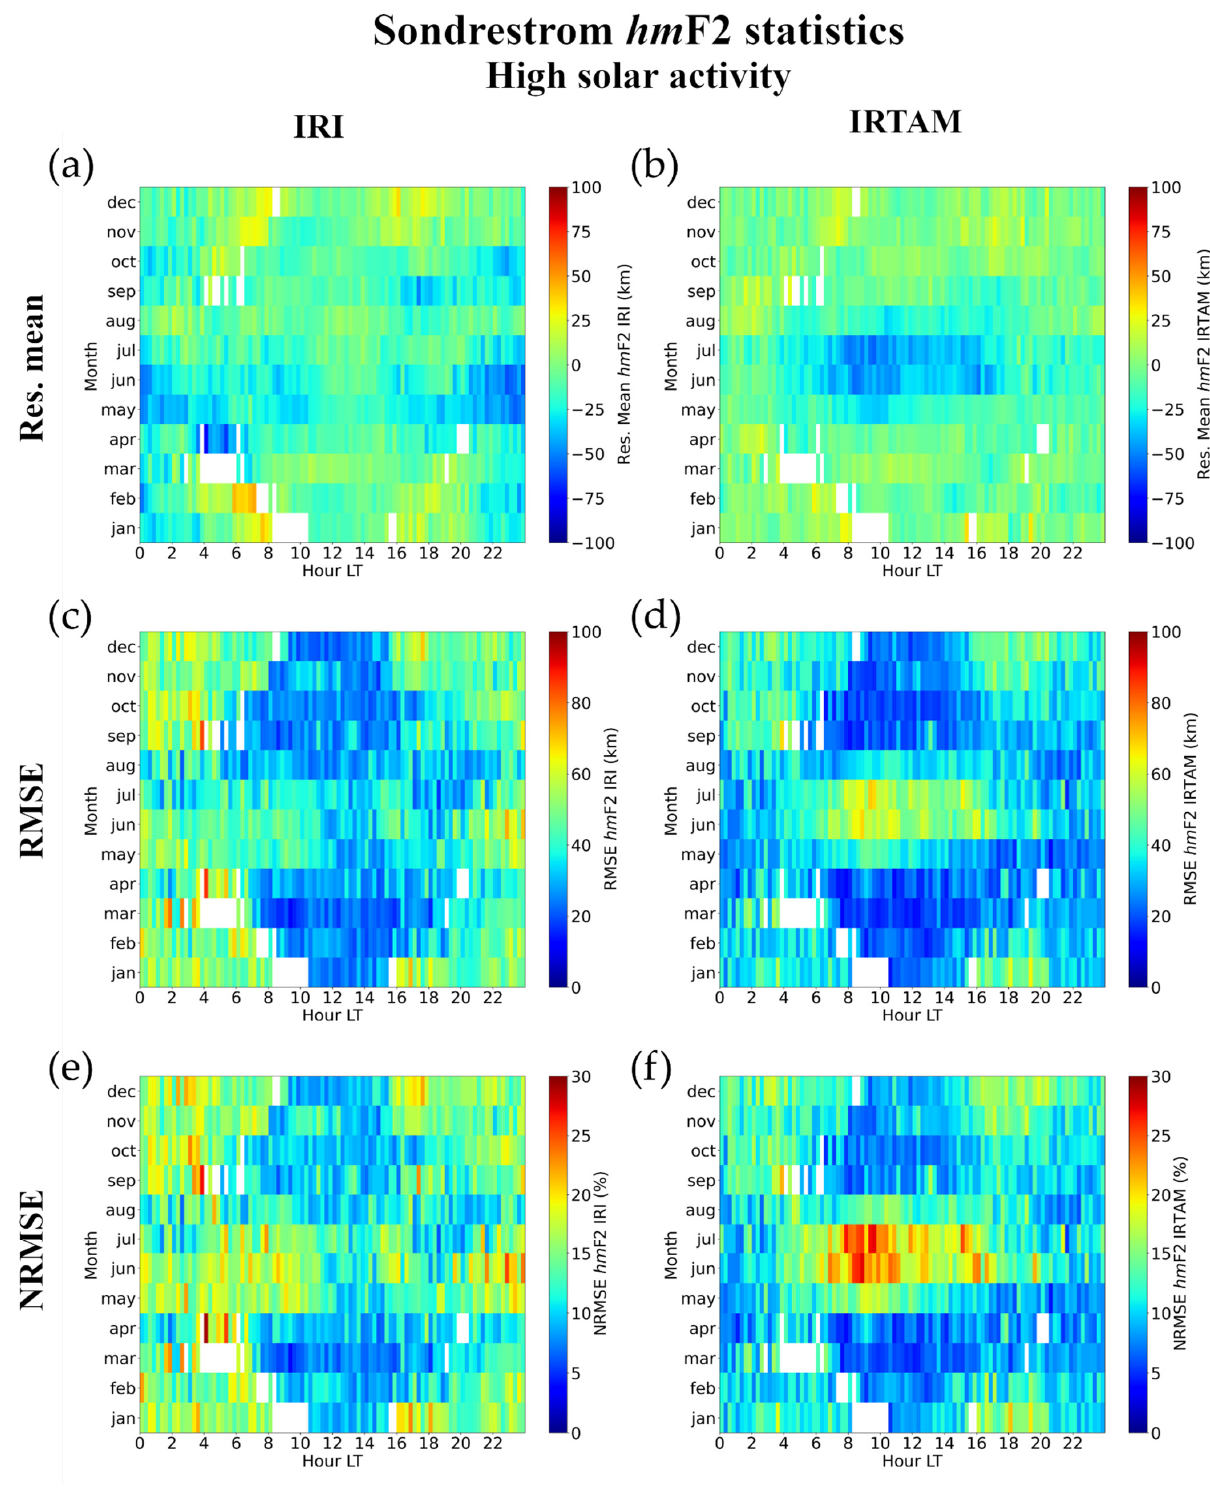
Figure 36. Same as Figure 34 but for HSA level.